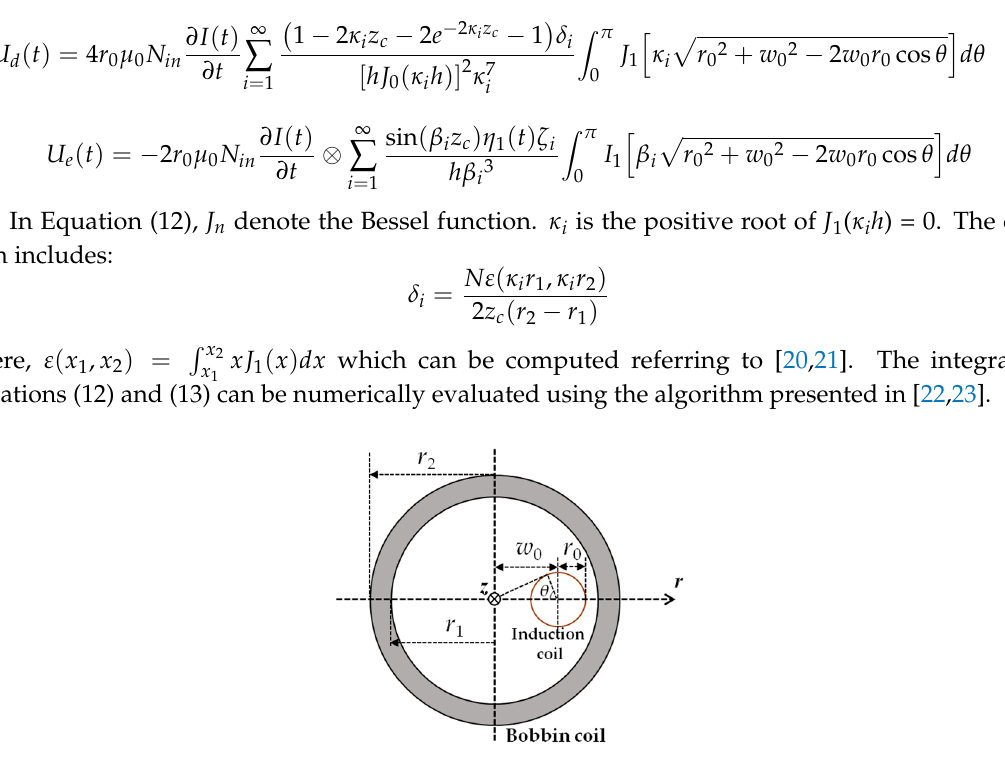
Figure 4. Top view of the bobbin coil and induction coil.